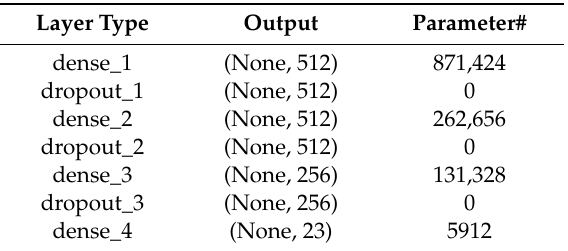
Table 2. The layer structure of MLP_S.